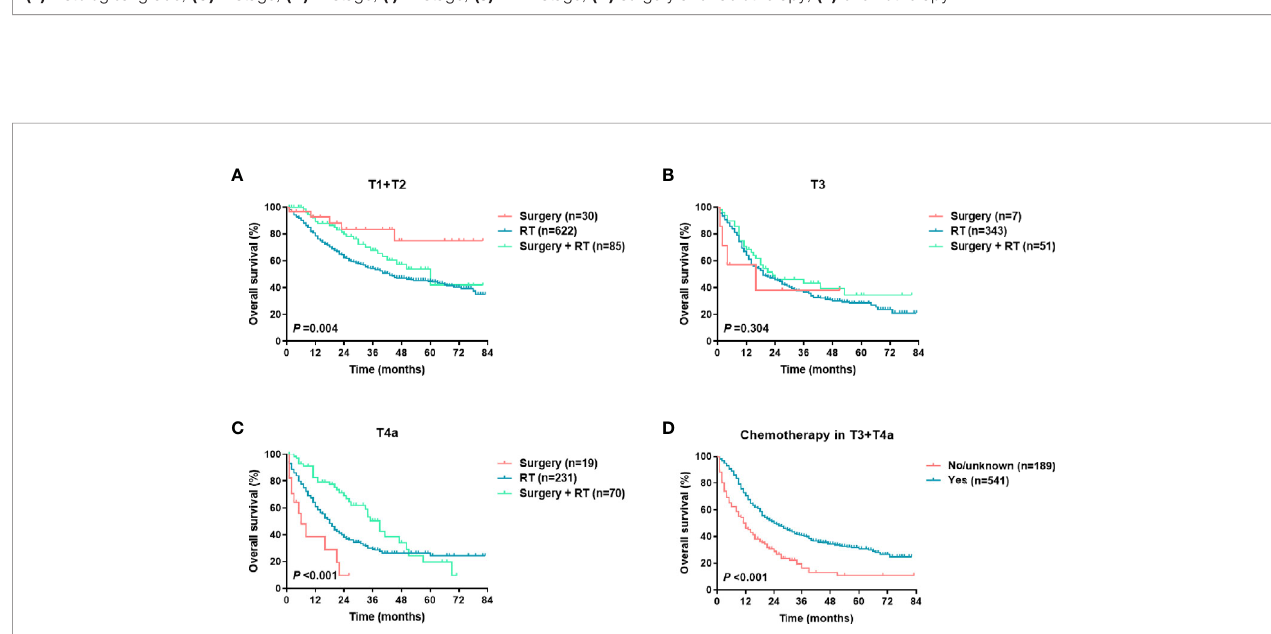
FIGURE 3 | OS of metastasis-free HSCC patients in different treatment groups (per T stage): (A) local treatment for T1 and T2 disease; (B) local treatment for T3 disease; (C) local treatment for T4a disease; (D) chemotherapy in T3 and T4a